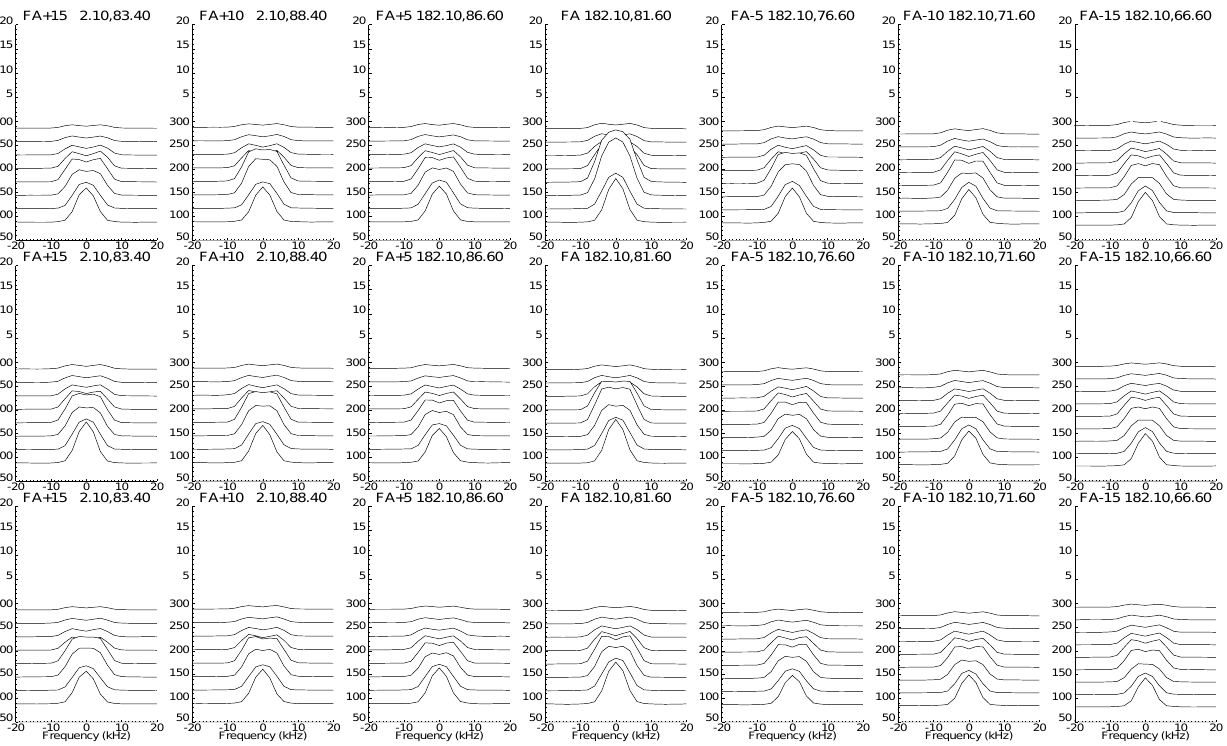
Fig. 8. Ion line spectra from scanning cycles 1, 4 and 5 from interval 2. The data are displayed using the same format and labelling as that applied in Fig. 7. The main features here are the probable SPEAR-induced F-region enhancements in FA+15, FA+10, FA and FA − 5, with the highest amplitude occurring in FA. These data are generally characterized by increases in the amplitudes of the ion-acoustic peaks and of the central part of the spectrum. There is evidence of an E-region throughout the three cycles, but this appears to be unaffected by the SPEAR high-power